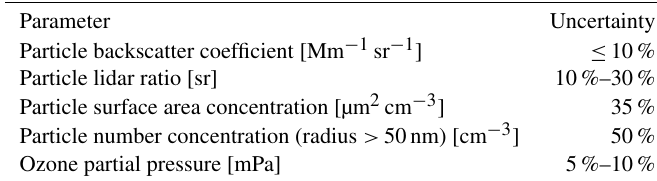
Table 1. Overview of Polly observational products and characteristic (typical) relative uncertainties in the determined and retrieved proper- ties. Basic smoke parameters measured with lidar are the particle backscatter coefficient and lidar ratio at 532nm wavelengths. From these data, extinction coefficients are calculated and converted to surface area and number concentration profiles of the smoke particles. In addition, the ozone partial pressure measured with NDACC ozonesondes and used in our study is